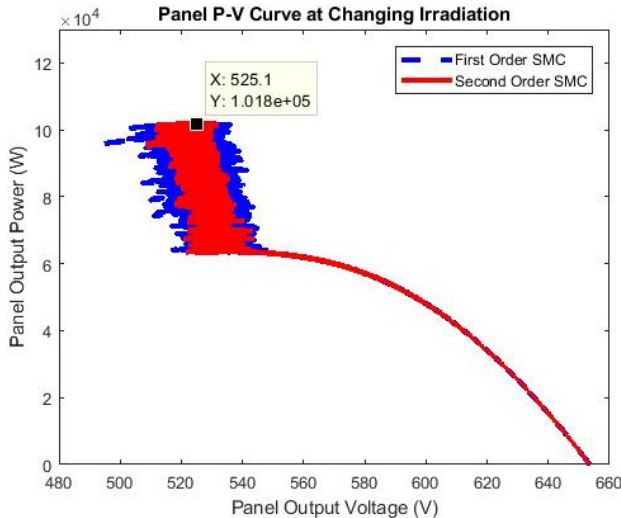
Figure 19. PV array I-V characteristic at 1000 W/m 2 .